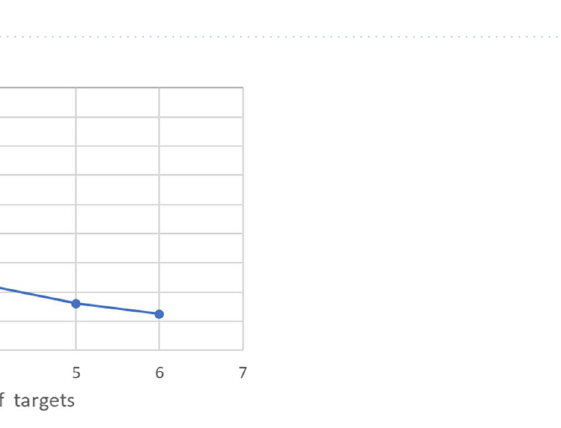
Figure 7. Computationally obtained relationship between number of antenna elements and residual incident wave level.